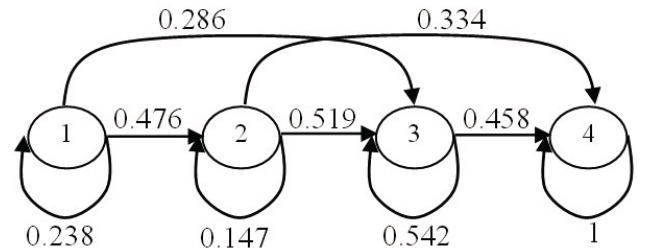
Figure 8. Structure and probabilistic parameters of an exercise